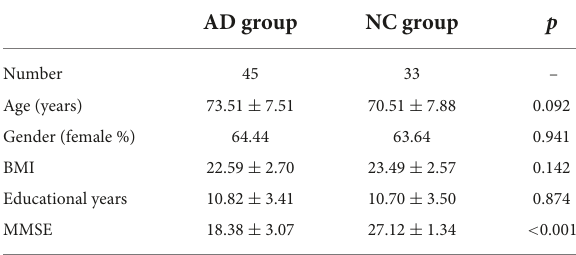
TABLE 1 Demographic and clinical